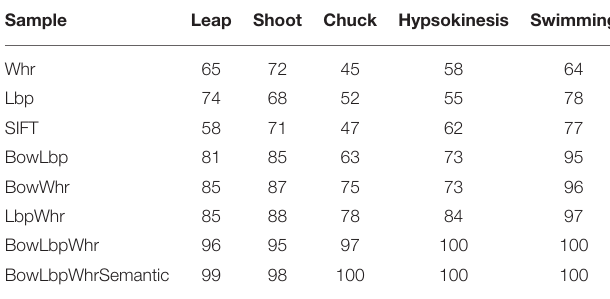
TABLE 6 | The classification result with SVM ( χ 2 ) on sports motion data